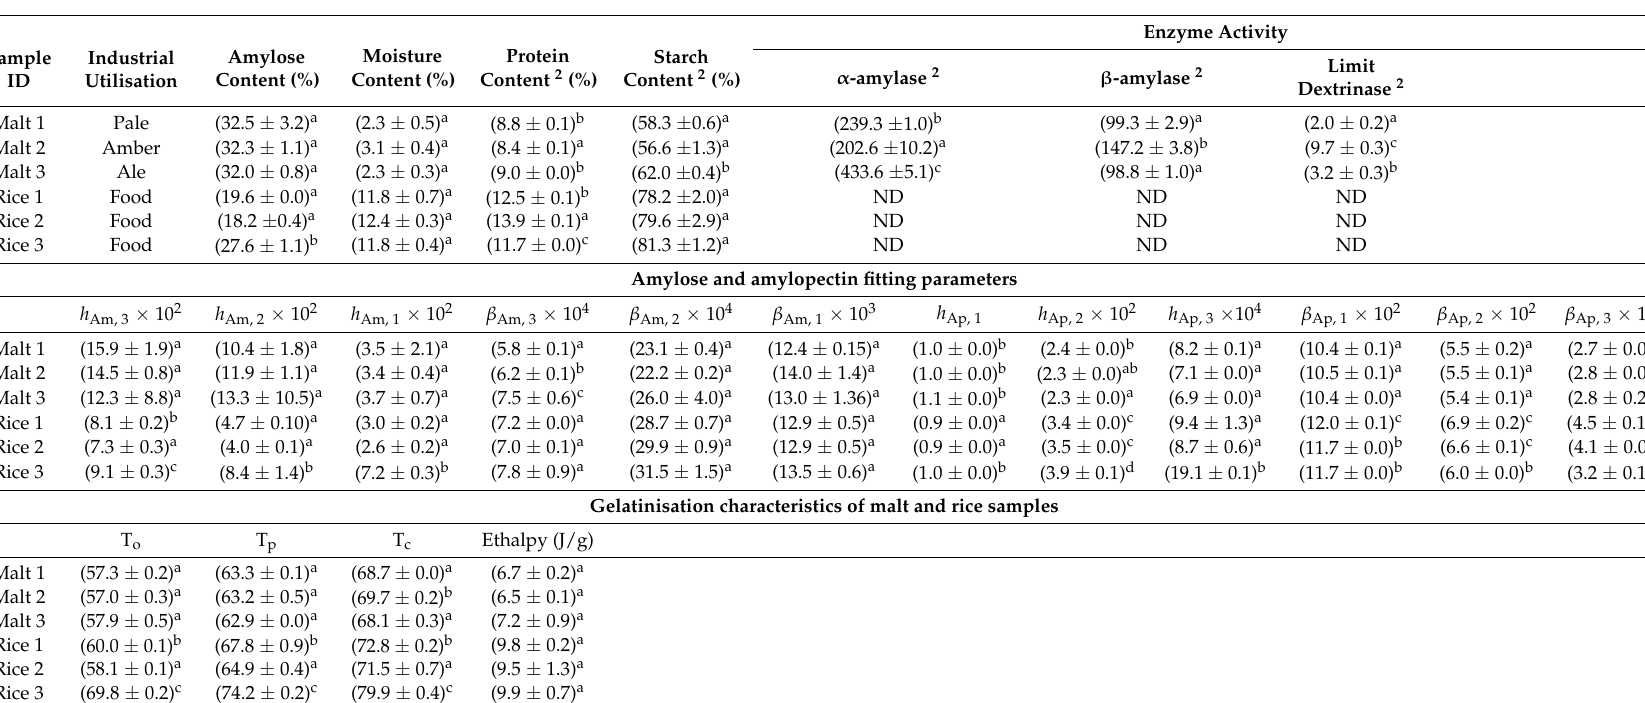
Table 1. Chemical compositions, starch structural parameters and gelatinisation characteristics of both barley malt and rice samples 1